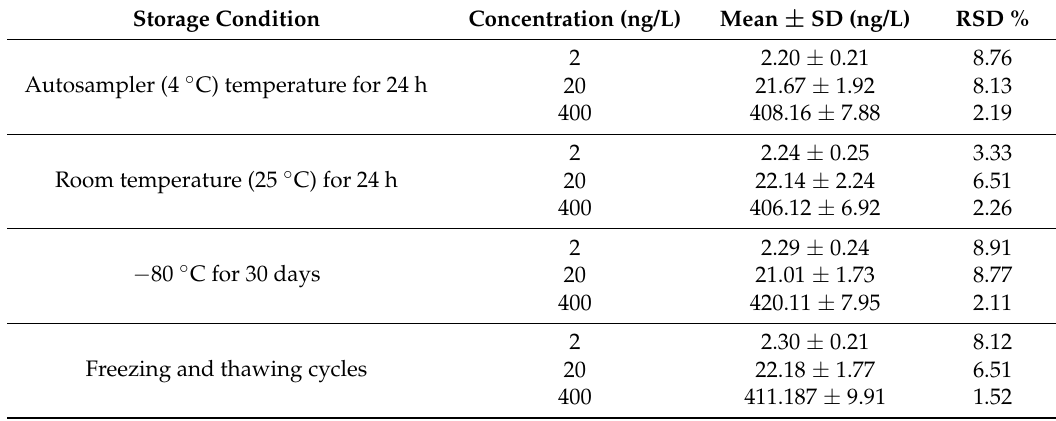
Table 3. Stability of vancomycin in serum under various storage